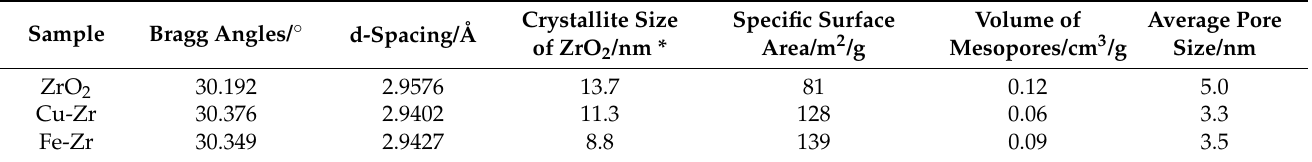
Table 1. Structural and textural properties of ZrO 2 , Cu-Zr and Fe-Zr calcined catalyst. Sample Bragg Angles/ ◦